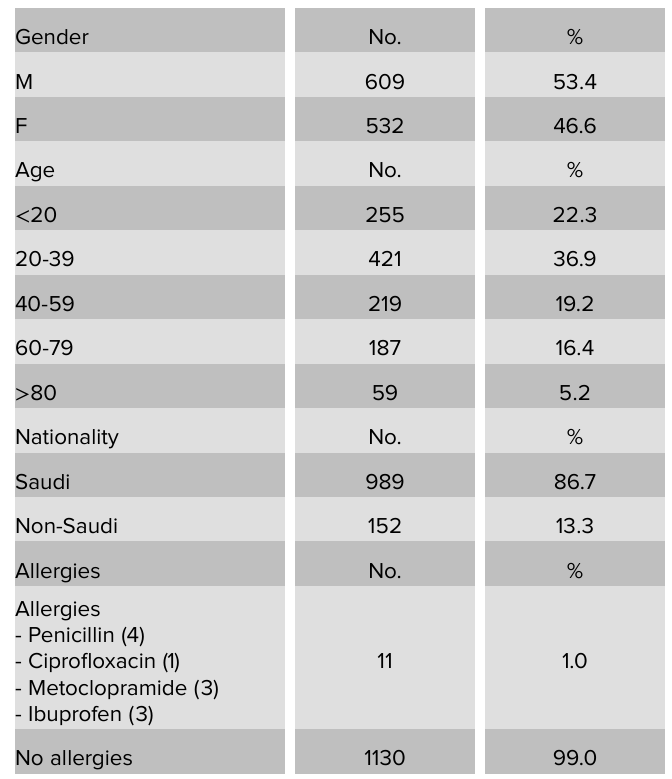
Table 1: Demographic data of ceftriaxone encounters (total of